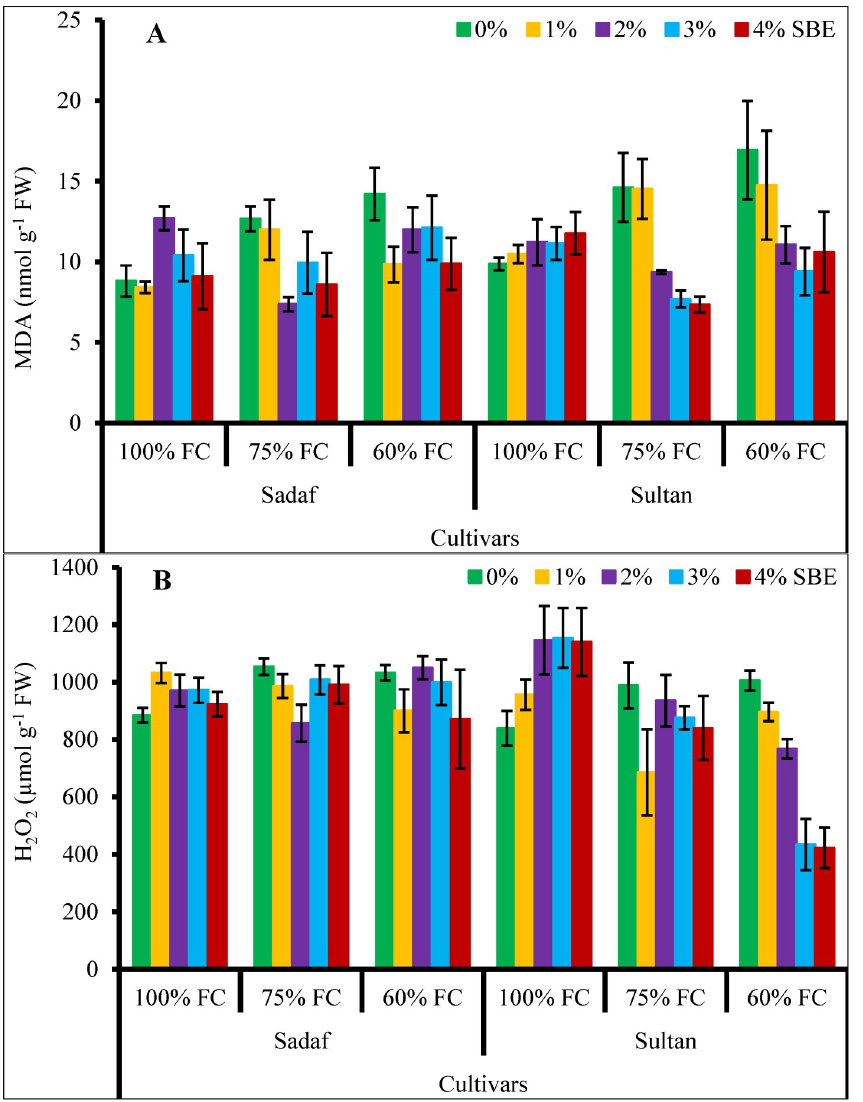
Fig 5. Sugar beet extract (SBE) regulates accumulation of (A) malondialdehyde (MDA) and (B) hydrogen peroxide (H 2 O 2 ) content of maize plants subjected to water-deficit stress ( n = 3; Mean ± S.E.).